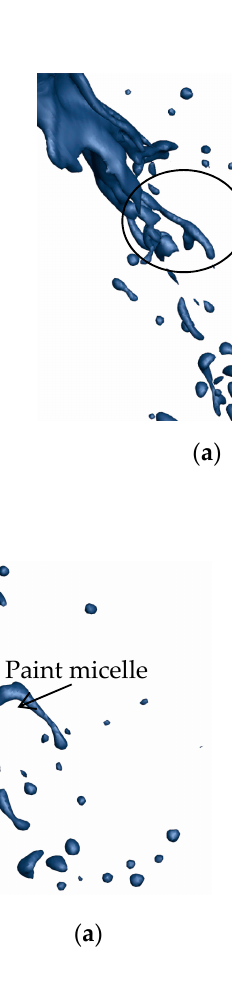
Figure 14. Formation process of paint droplets: ( a ) 2.084 ms, ( b ) 2.098 ms, ( c ) 2.107 ms, and ( d ) 2.118 ms.